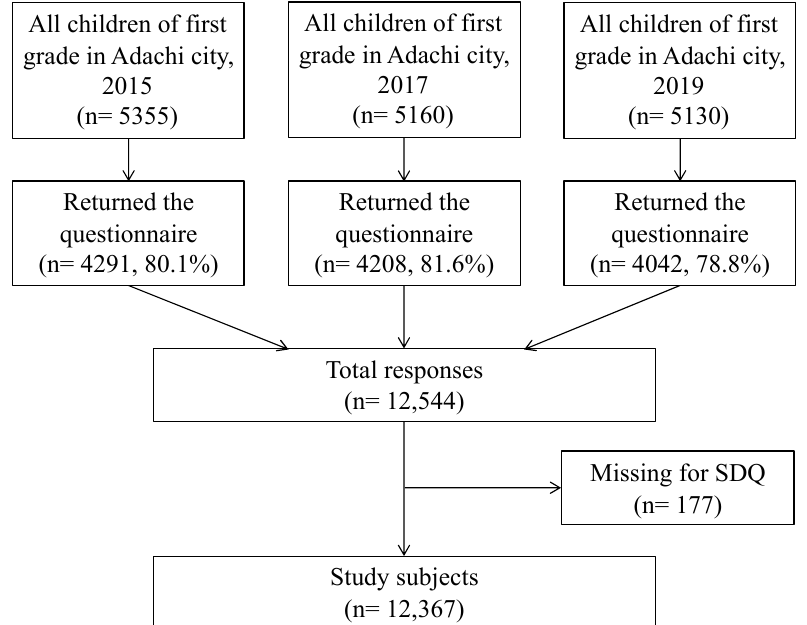
Figure 1. Flowchart of the study subjects.